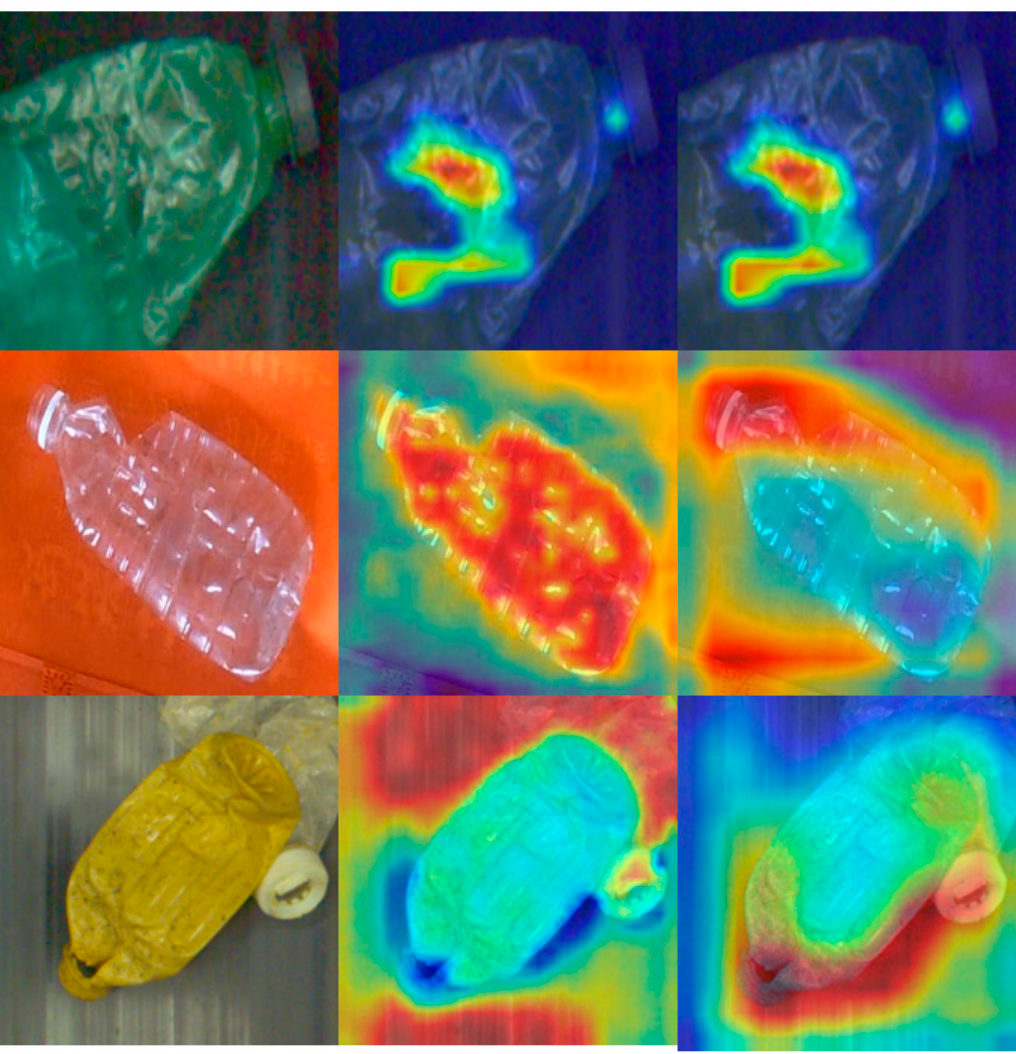
Figure 4. One bottle image (on the left) and its grad cam map of a waste bottle with the damaged classification on the last layer of RB (in the middle) and on the last layer of MAB (on the right). Our model can precisely locate the “damaged area” and the MAB makes it more focused (we mark relatively unimportant pixels for classification in blue and relatively important ones in red).